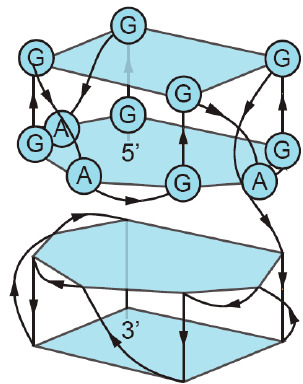
Figure 9. Structure of a dimeric GQ formed by the sequence (GGA) 8 . See [64] and [107] for more information about this